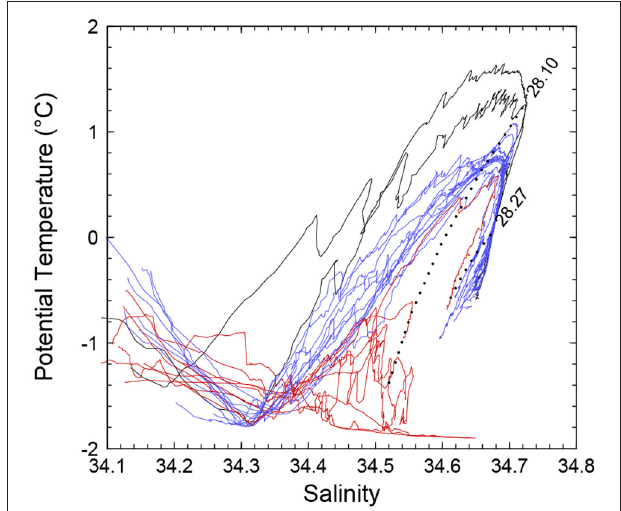
FIGURE 2 | θ - S diagrams for all CTD stations. Black, blue, and red lines indicate data in the offshore, slope, and shelf regions. The potential temperature and salinity at depths shallower than 40 m are not shown. The dotted lines indicate the contours of γ n